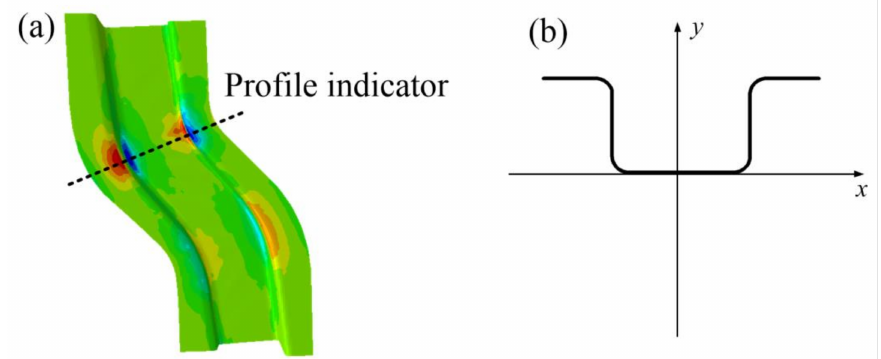
Figure 22. Schematic diagram of cross-sectional position ( a , b ) at optimal forming conditions (stamping speed of 50 mm/s, friction coefficient of 0.1, and blank holder force of 5 kN, forming temperature 410 ◦ C).